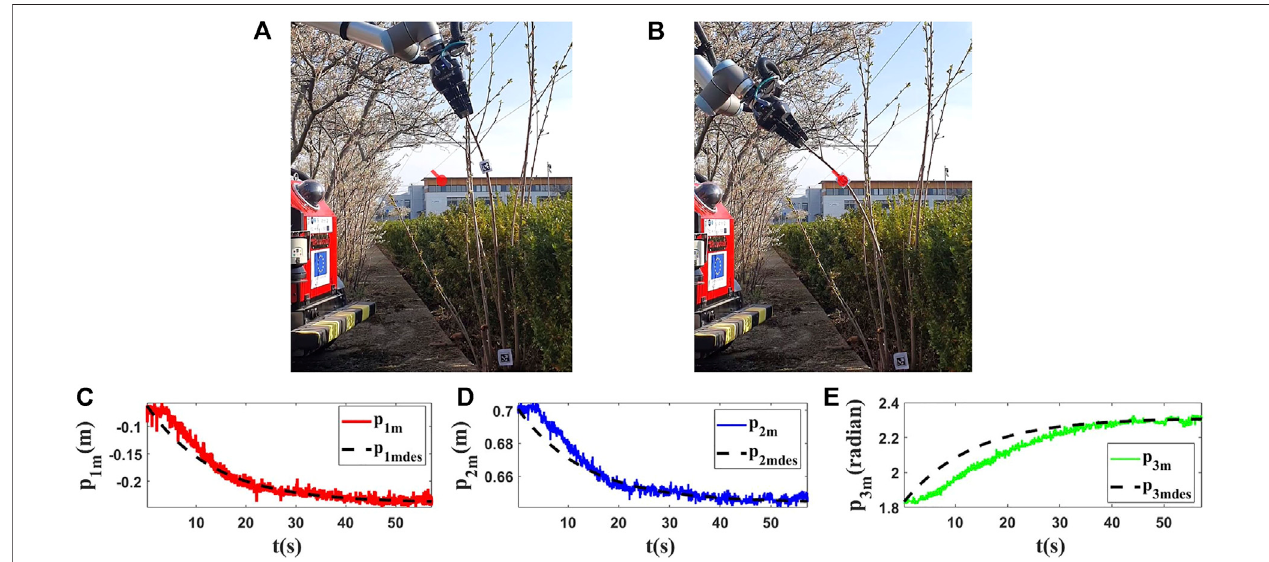
FIGURE15| Experiment6.Firstrow: (A) and (B) aretheinitialand fi nalshapeoftheobject,respectively.Thedesiredstateof m isshownasaredcirclewithasmall linesegment. Object ’ slength ( L ) is0.99( m ). We assume that M 0 is[ − 0.062,0.702,1.833] T and we want tomove itto M fdes = [ − 0.237,0.645,2.306] T . The fi nalstate ofthe controlled point is M f = [ − 0.241,0.646,2.309] T . Second row: (C) , (D) and (E) are the evolution of the states in the last test with respect to their desired